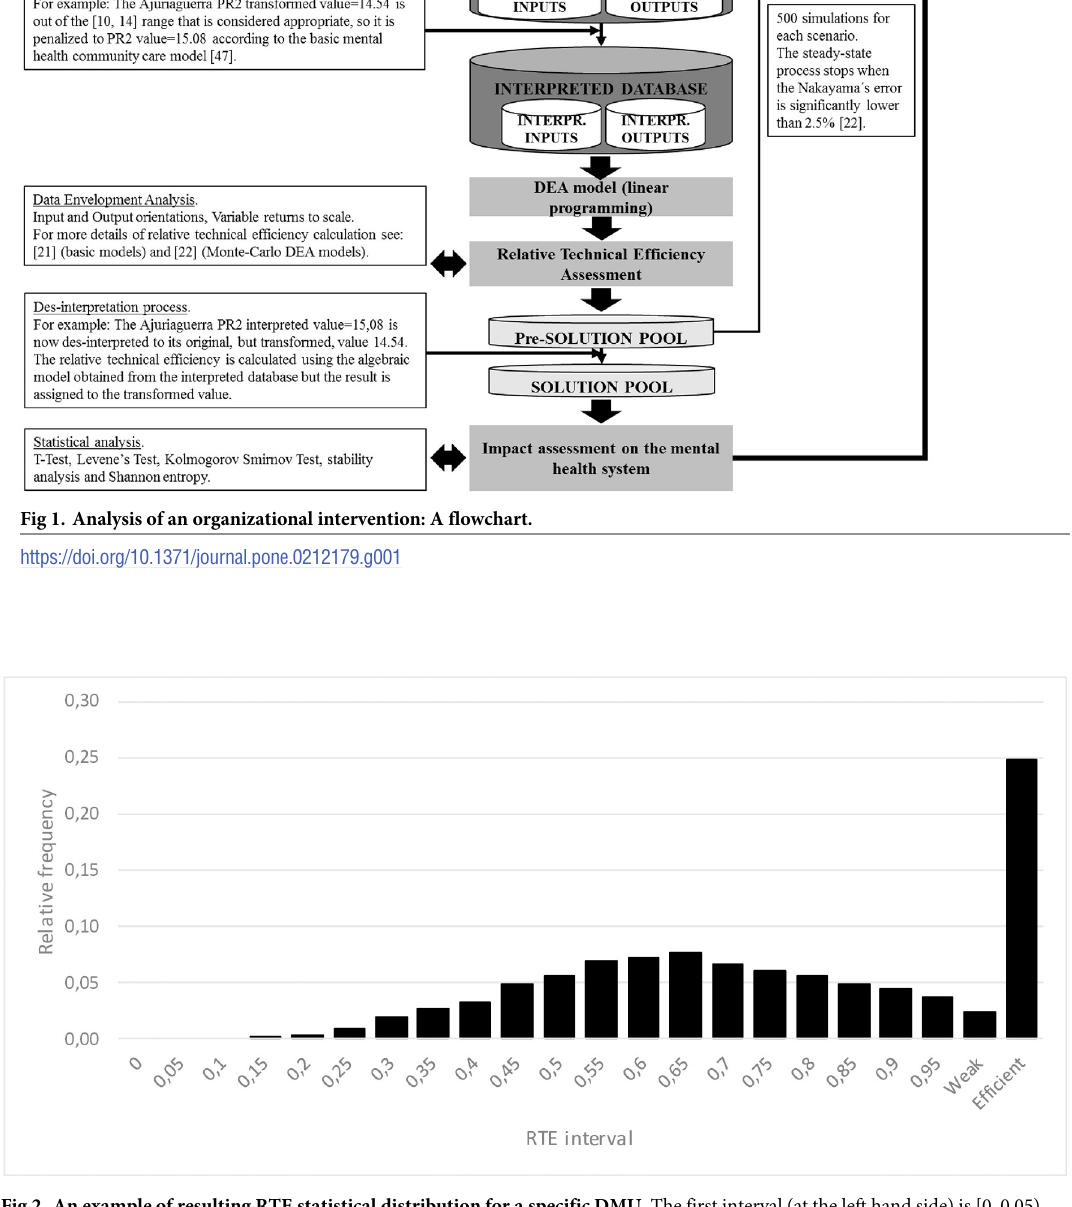
Fig 2. An example of resulting RTE statistical distribution for a specific DMU. The first interval (at the left hand side) is [0, 0.05), the second is [0.05, 0.1), ... , the antepenultimate is [0.95, 1), the penultimate represents the simulations where RTE = 1 but the sum of slacks are different to zero (weakly efficient) and, finally, the last interval represents the simulations where RTE = 1 and the sum of the slacks is equal to zero (completely efficient).